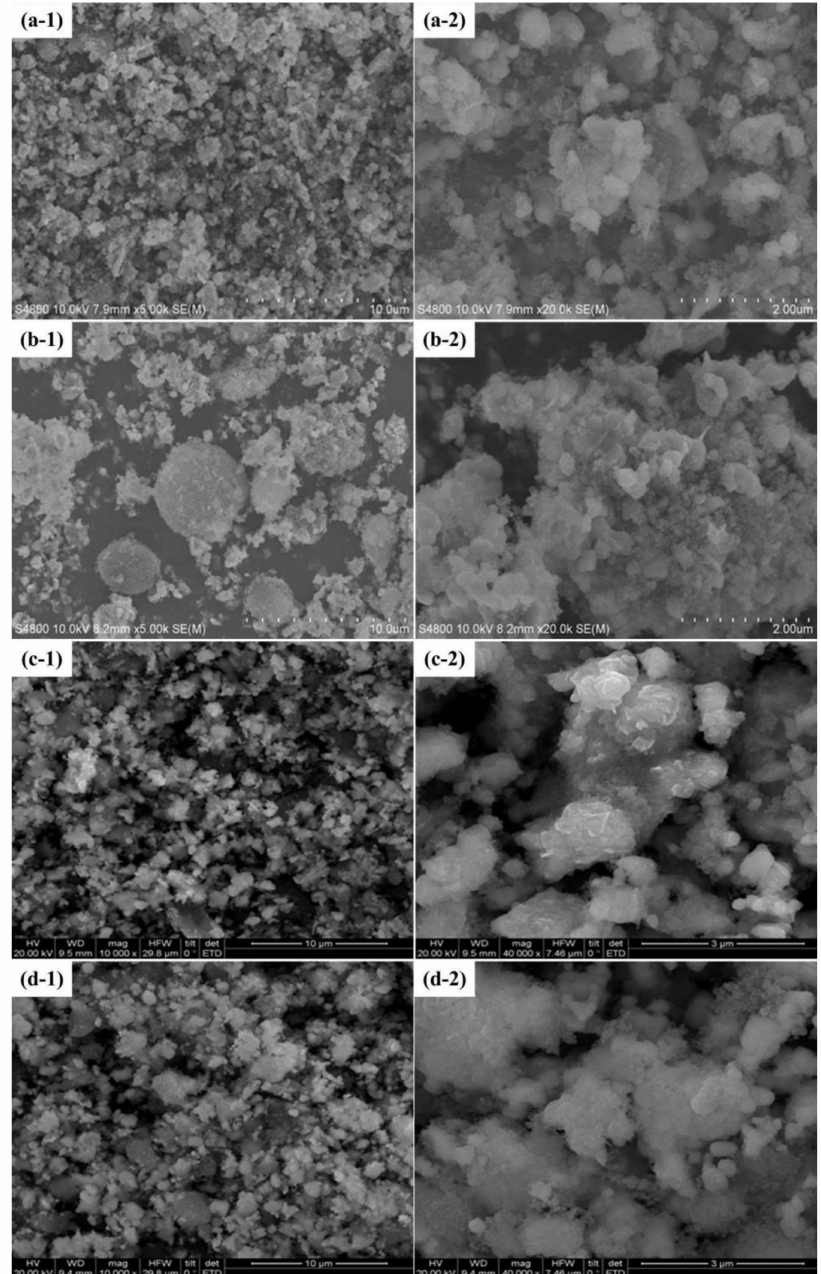
Figure 8. Microstructure of roasted products at different roasting times and temperatures: ( a-1 , a-2 ) and ( b-1 , b-2 ) denote the SEM images at roasting a temperature of 750 ◦ C, a roasting time of 120 min and 240 min, respectively; ( c-1 , c-2 ) and ( d-1 , d-2 ) denote the SEM images at a roasting time of 120 min, a roasting temperature of 850 ◦ C and 950 ◦ C,